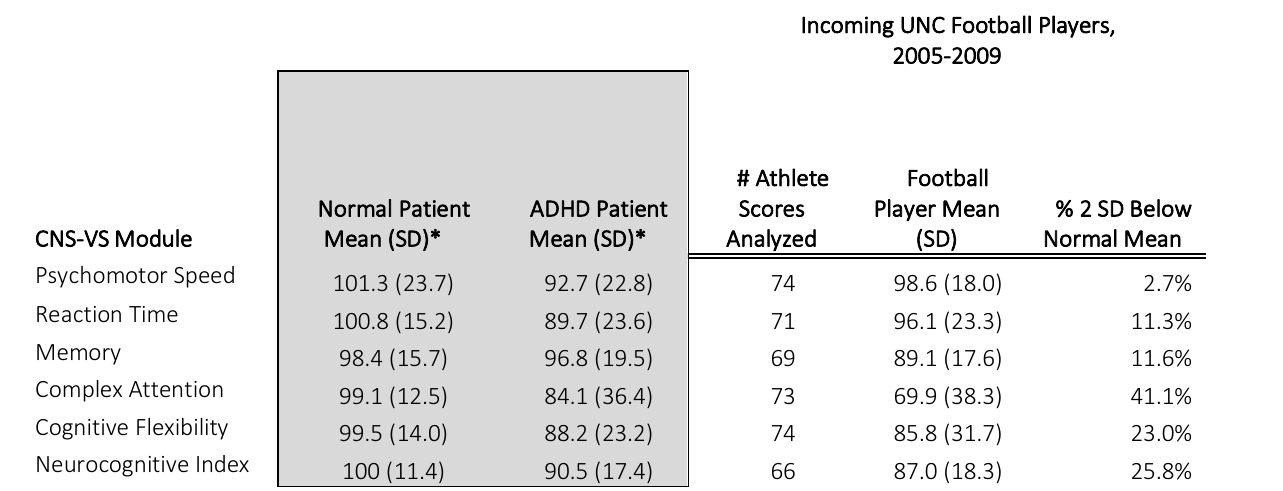
Table 2: Comparison of Normal & ADHD Patients and UNC Football Player Scores on CNS-VS